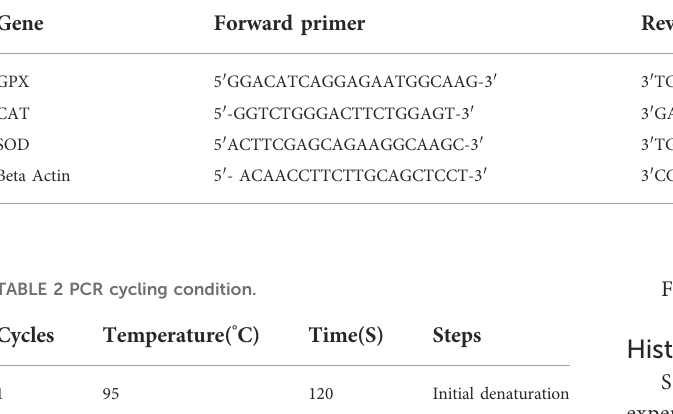
TABLE 1 Showing primers for each gene with their product size.